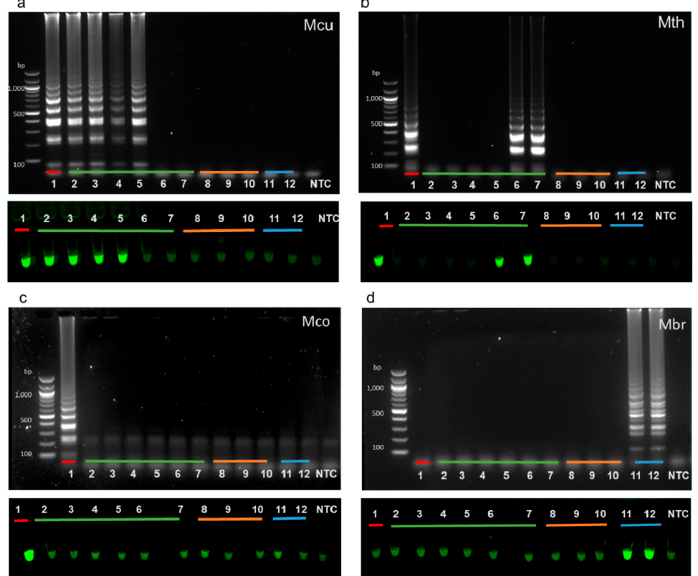
Figure 5. LAMP assay outputs comparing agarose gel electrophoresis (top of panels) and Sybr Green I end-point detection (bottom of panels). Assays used primers targeted to species with the genera Methanoculleus ( a ), Methanothermobacter ( b ), Methanococcus ( c ), and Methanobrevibacter ( d ). Assays were performed with Bst 3.0 ( a , c , d ) or Warm Start Bst 2.0 chemistry ( b ). Genomic DNA (20 ng) from Methanoculleus ( a ) , Methanothermobacter ( b ), or Methanococcus ( c ) was used as a positive control (lane 1, red line). LAMP assays were performed with metagenomic DNA from process scale mesophilic digesters (lanes 2, 3), lab-scale mesophilic digesters (lanes 4, 5), lab-scale thermophilic anaerobic digesters (lanes 6, 7; green line), salt marsh sediment (lanes 8, 9; orange line), garden soil (lane 10; orange line), or human stool samples (lanes 11, 12; blue line). A non-template control (NTC) was included in all